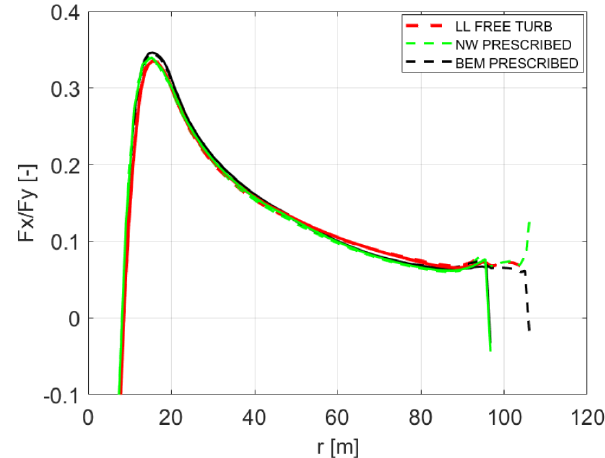
Figure 21. Mean values of the aerodynamic efficiency, Fx/Fy . Solid lines represent the baseline blade, while dashed lines represent the optimized tip